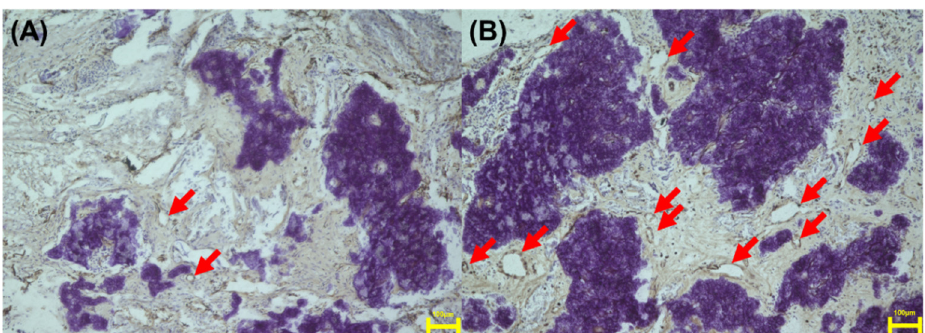
Figure 16. Tissue specimen of immunostaining (Factor VIII). ( A ) α -TCP/GS group and ( B ) α -TCP/GS + DFAT group. α -TCP/GS, composite gelatin sponge; GS, gelatin scaffolds; and DFAT, dedifferentiated fat cell. Arrows indicate blood vessels. The scale bar represents a length of 100 µ m.